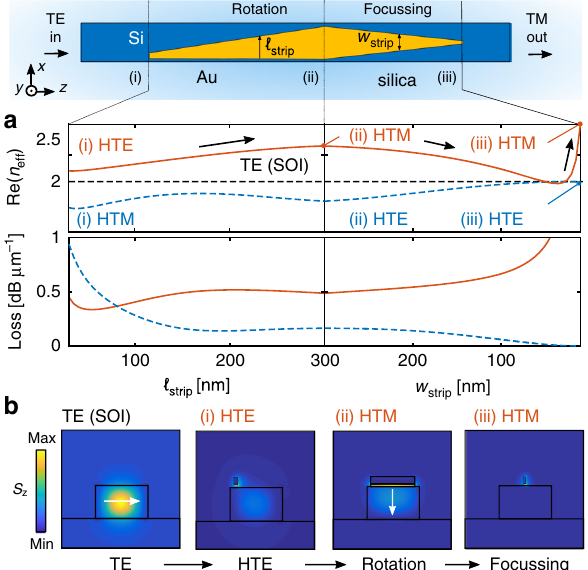
Fig. 2 Two-dimensional calculations of relevant optical modes. Þ and loss for relevant modes ( λ = 1.32 a Calculated effective index R e ð n eff μ m). Red line: a TE mode at input (TE SOI) (i) couples to a hybrid TE (HTE) mode, (ii) evolving to a rotated hybrid TM (HTM) mode, and (iii) transitions to a nano-focused HTM plasmonic mode. The dashed blue line shows the HTM-to-HTE evolution. b Corresponding mode pro fi les as labeled. White arrows represent the dominant electric fi eld direction. The color represents the z -component of the time-averaged Poynting vector S z . Window size: 0.8 × 0.8 μ m 2 . See Fig. 1 caption for relevant parameters. surface with respect to the peak intensity in the silicon for the TE- SOI input. Figure 3c shows S z in each xy cross-section as indicated by the dashed lines in Fig. 3a(i) – (iv). We calculate the conversion ef fi ciency between the incoming TE-SOI mode and each of the participating modes in the full device by performing overlap integrals between the calculated 3D fi elds of Fig. 3c and the 2D modes of Fig. 2, as outlined in ref. 34 .